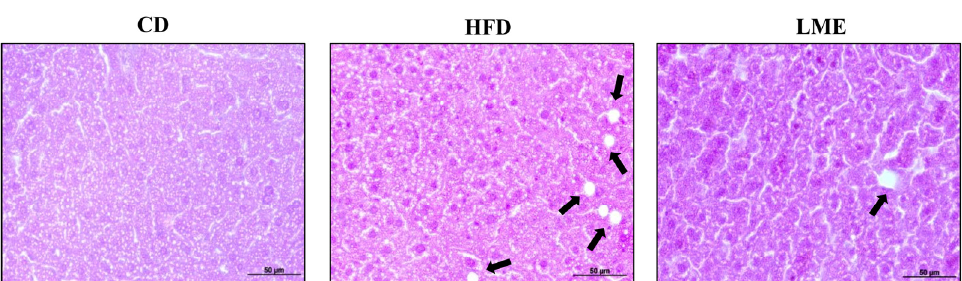
Figure 6. Effects of LME administration on fat deposits in liver tissue stained with hematoxylin and eosin. The black arrows indicate the presence of lipid vacuoles in the cytoplasm of hepatocytes in high-fat diet (HFD)-fed mice.